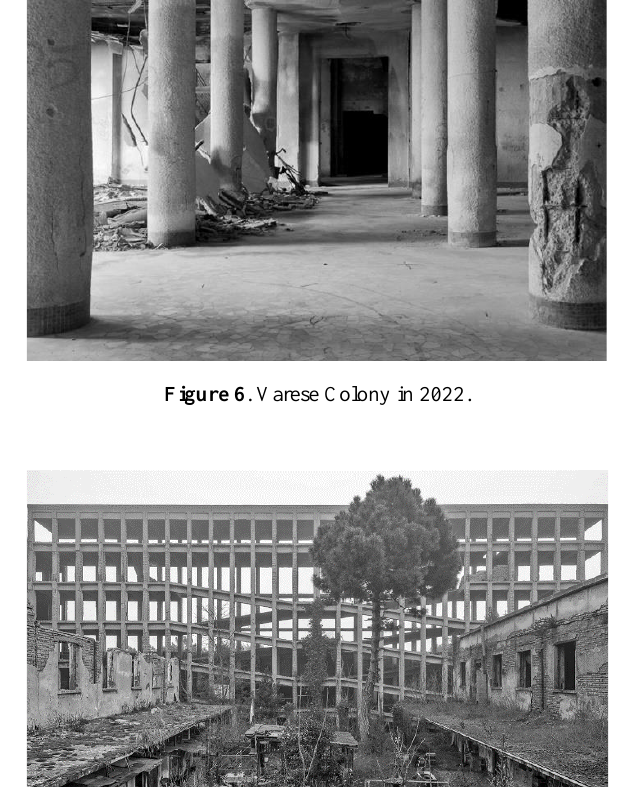
Figure 7 . Varese Colony in 2022.